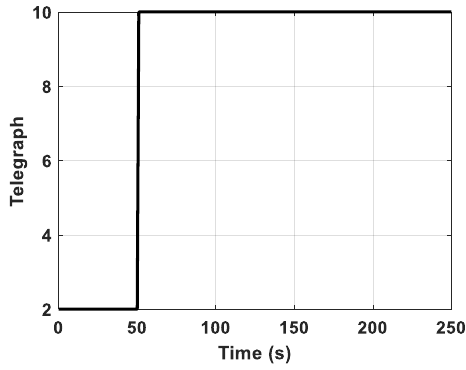
Figure 4. Bridge lever position.